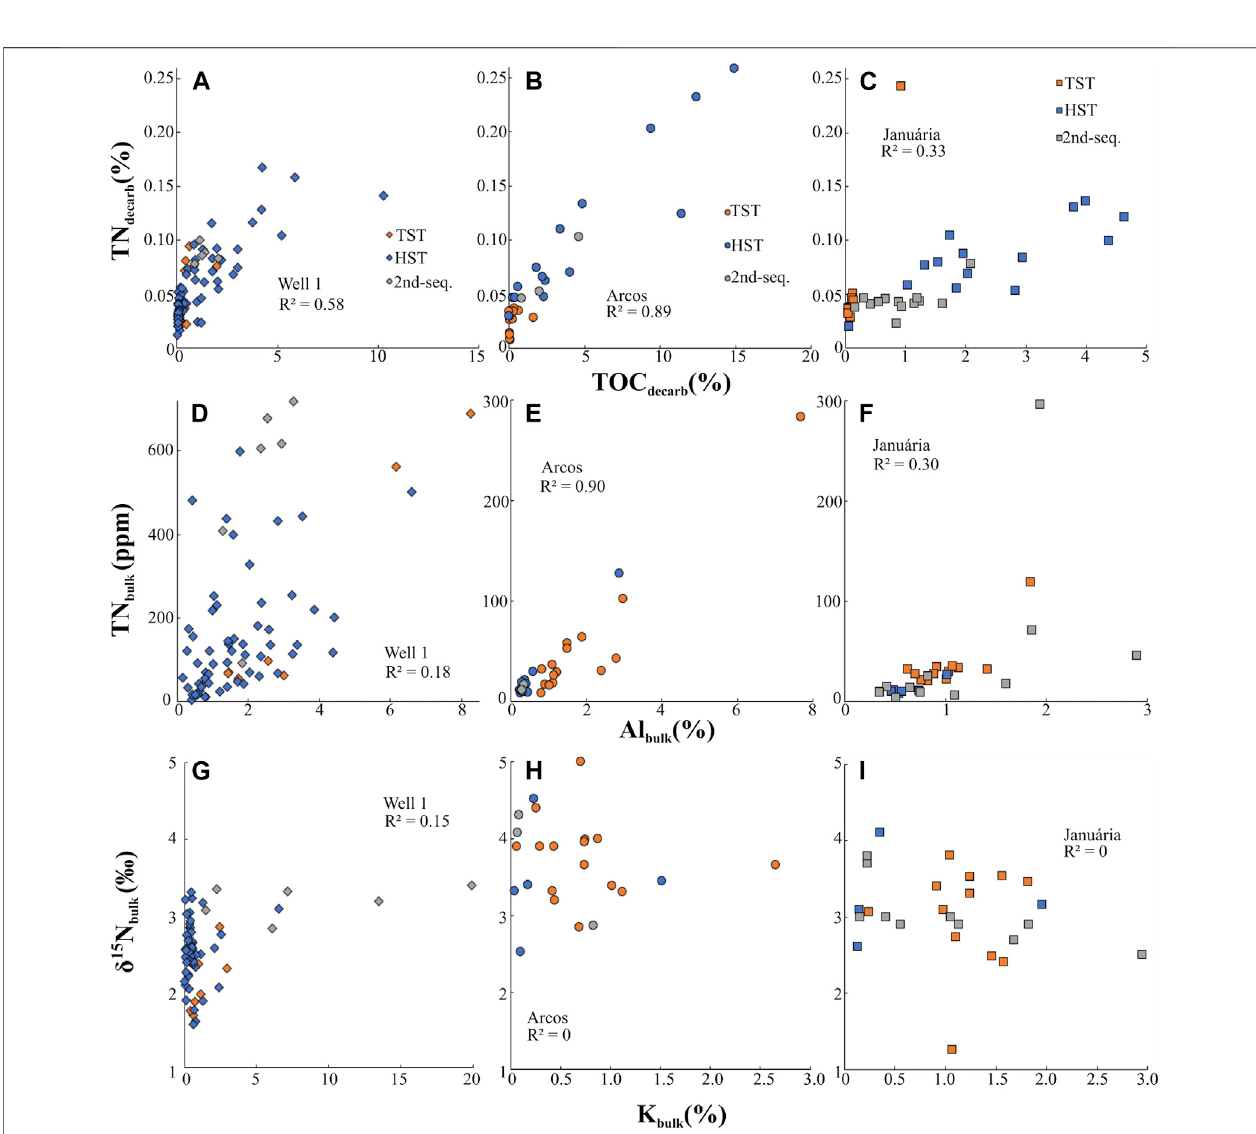
FIGURE 7 | Analyses of total nitrogen (TN), total organic carbon (TOC), Al, K and δ 15 N in Well 1, Arcos and Janu (cid:1) aria sections.